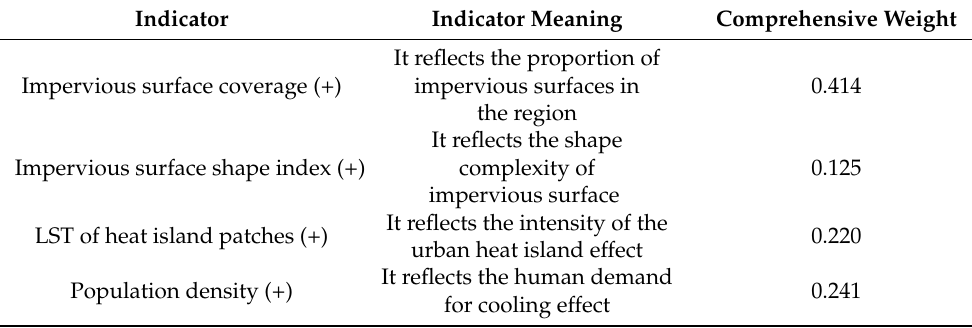
Table 2. Cold island demand capacity (CID) index